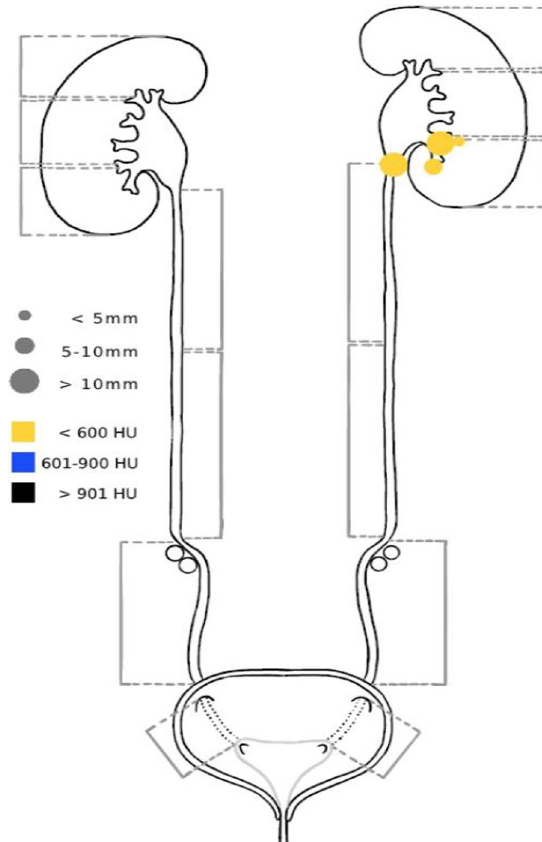
Fig. 1 Graphic visualisation aid for urolithiasis CT. In the shown case, the radiologist has highlighted four stones of different sizes and low density in the left kidney and left proximal